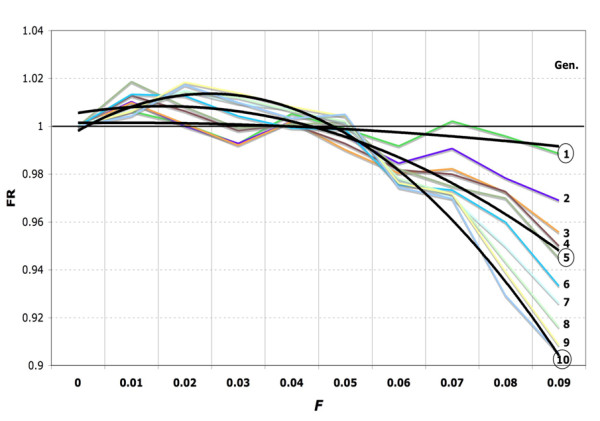
Inbred/outbred fitness ratios (FR) of populations with a high α+-thalassemia frequency over ten generations. At the start of simulation, the frequency of α+-thalassemia is 0.5. The black lines are trends for the first, fifth and tenth generation. FR > 1 is seen in every generation for all 0 <F < 0.05. This graph demonstrates robustness of inbreeding elevation found at all levels of inbreeding which were observed in human field studies, i.e., 0 <F ≤ 0.045 [13,14].